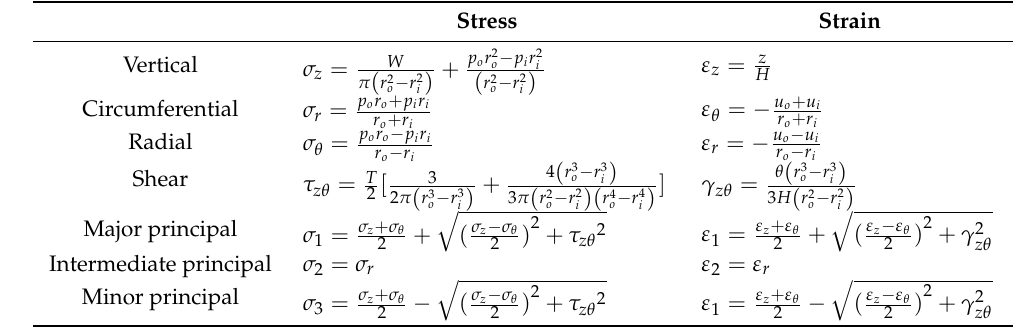
Table 2. Equations for data interpretation.